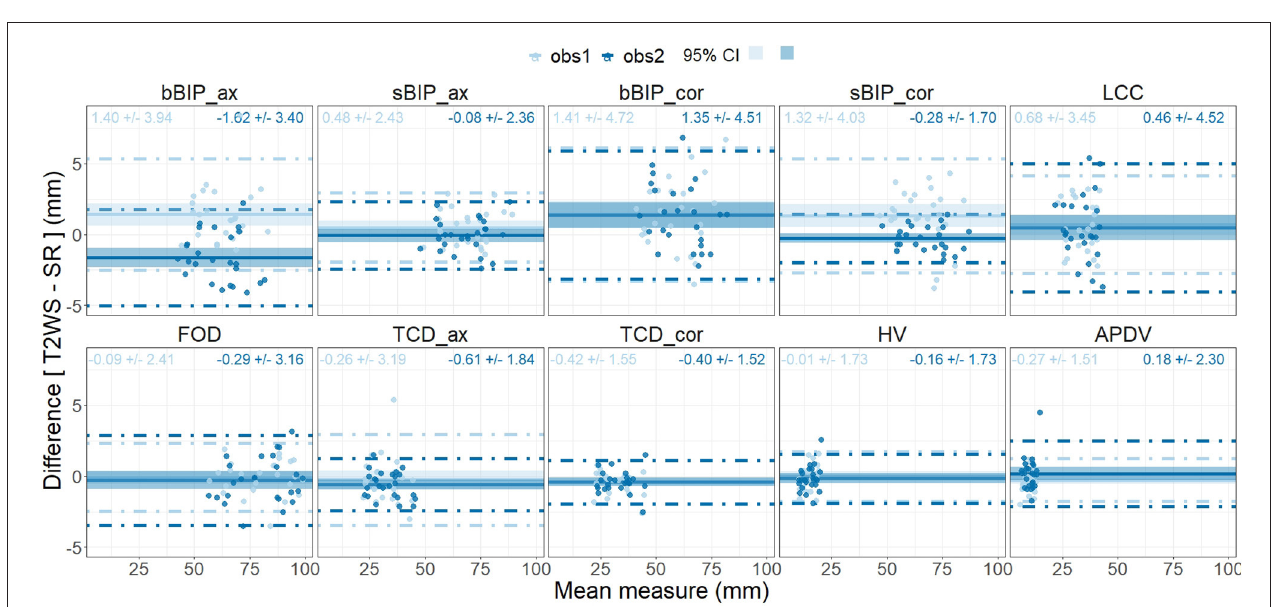
FIGURE 5 | Inter-dataset intra-observer comparison for each biometric measurement using the paired Wilcoxon signed rank test. Vertical y-axis, value in mm of each biometric measurement for each fetal brain exam (point) for observer 1 (obs1) and observer 2 (obs2) (horizontal x-axis) for T2-weighted sequence (T2WS; orange) and super-resolution (SR; blue). Solid horizontal lines depict the median; diamonds depict the average of measurement in mm. See Figure 3 for measurement abbreviations. p < 0.05 is considered significant.